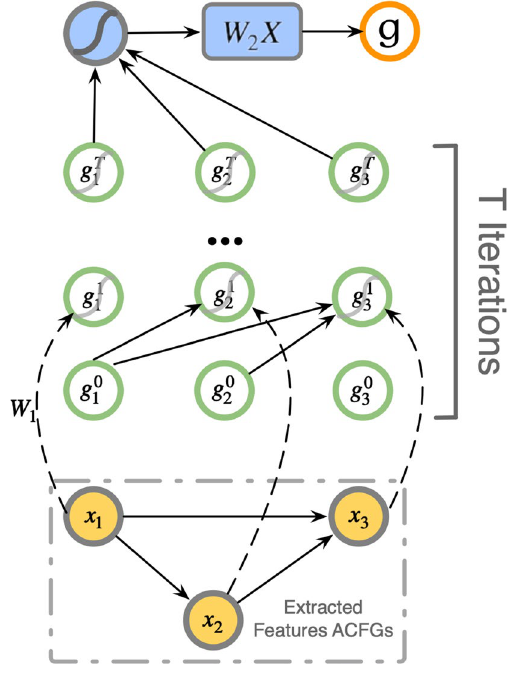
Fig. 4 Architecture of structure2vec for structural attribute